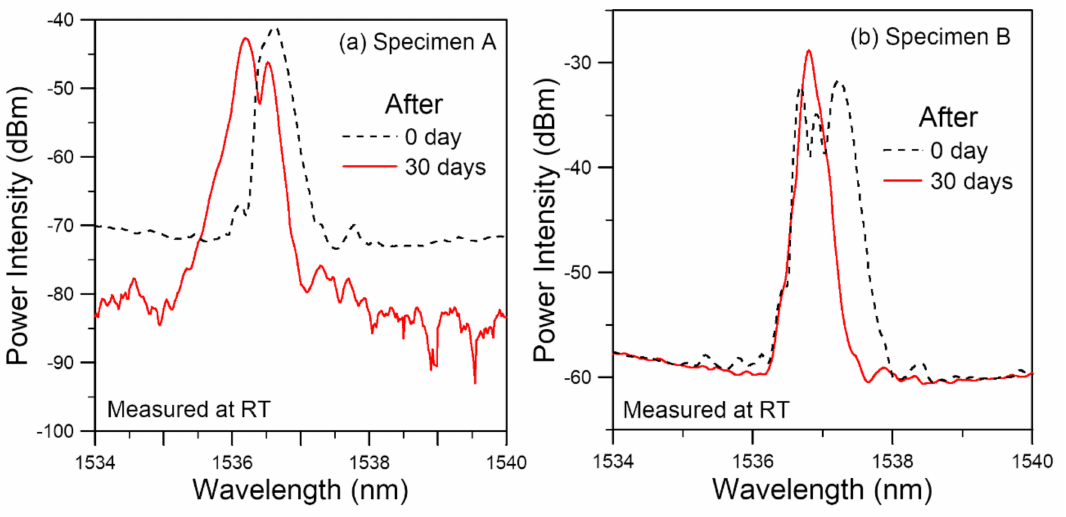
Figure 7. Comparison of room temperature FBG spectra before and just after soaking at 60 ◦ C for 30 days from specimens ( a ) A, which shows a marked broadening and peak splitting; ( b ) B, whichs shows a spectrum narrowing and merging of split